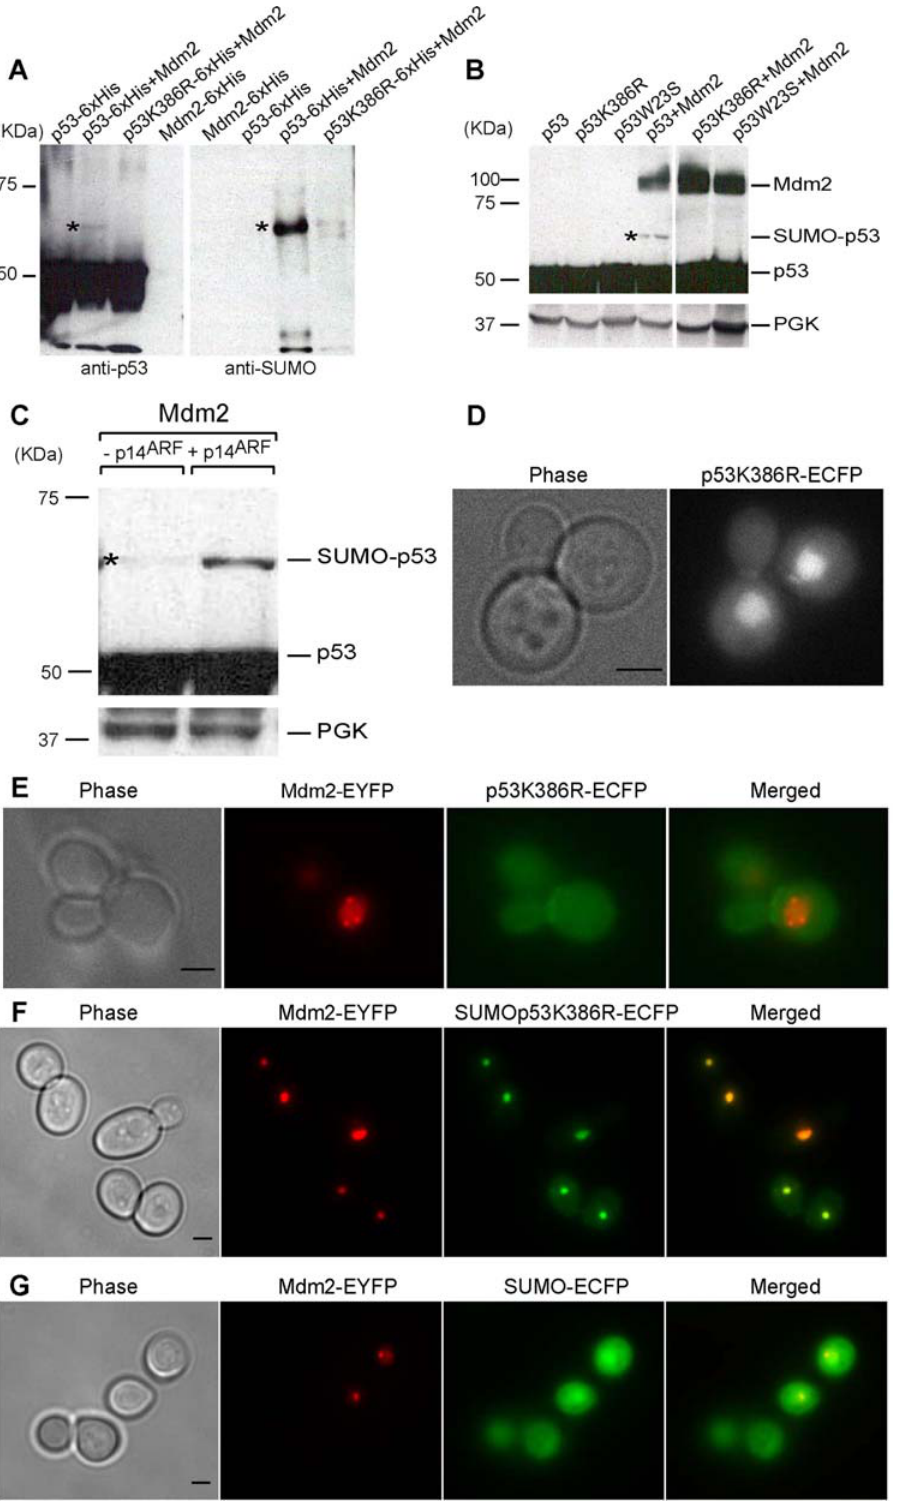
Figure 6. Mdm2 sumoylates p53 in yeast on lysine 386 and sumoylation is required for p53-Mdm2 complexes recruitment to yeast nuclear bodies. (A) His-tagged proteins were purified from cell extracts and analyzed by immunoblotting using anti-p53 and anti-Smt3 antibodies. (B,C) Sumoylated p53 (asterisks) as detected by immunoblotting on crude yeast lysates. An irrelevant lane was cut off as indicated by a space. PGK immunoblotting served as loading control. (D–G) Maximum projections from fluorescence image stacks of live yeast cells expressing the indicated fusion proteins were obtained with a DeltaVision workstation. Bar, 2 m m.